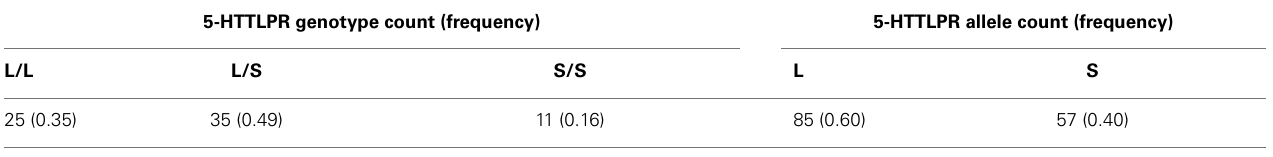
Table 1 | Distribution of 5-HTTLPR and 5-HTTLPR/rs25531 alleles and genotypes. 5-HTTLPR genotype count (frequency)